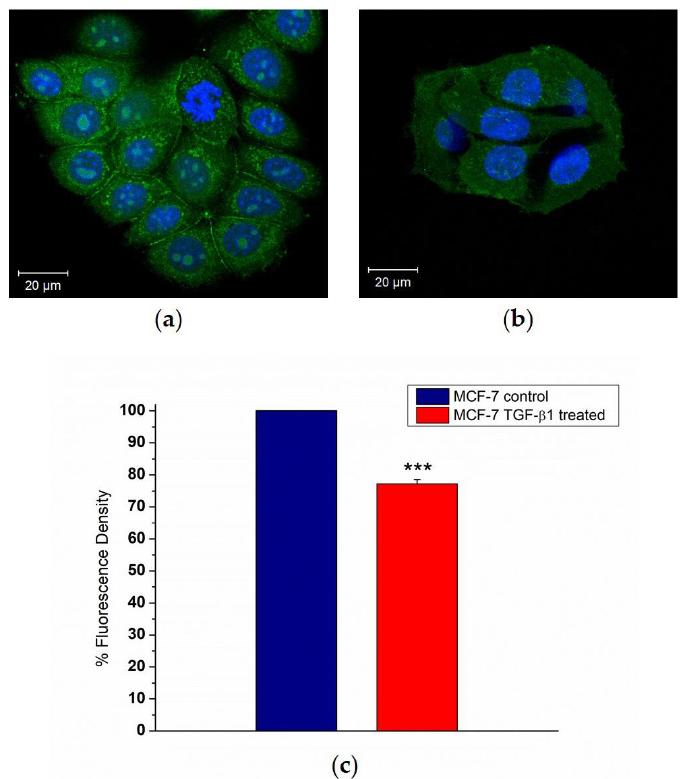
Figure 1. Representative images of immunofluorescence staining of E-cadherin (green) in MCF-7 CTR ( a ) and treated with TGF-β1 (5 ng/mL for 48 h), MCF-7 TGF-β1 cells ( b ). Nuclei are labeled in blue. The images were acquired by Zeiss LSM700 (Zeiss, (Carl Zeiss, Oberkochen, Germany) confocal microscopy. The fluorescence density of E-cadherin ( c ) was quantified by ImageJ specific tool and expressed as a percentage with respect to the control (100%). Results were statistically significant for p < 0.05 (<0.05 *, <0.01 **, and <0.005 ***).